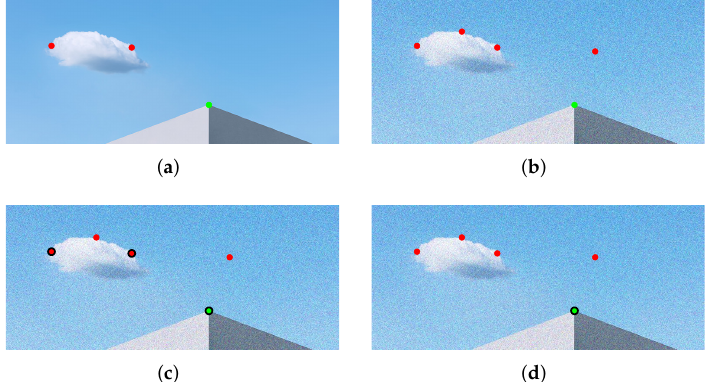
Figure 3. A comparison of the existing repeatability metric (REP) and our proposed repeatability metric (RGT). ( a ) Detection result on the original image. ( b ) Detection result on noise-corrupted version of the image. ( c ) The repeatedly detected corners between ( a , b ) (marked with black circles). ( d ) The repeatedly detected corner between ( b ) and ground-truth (marked with black